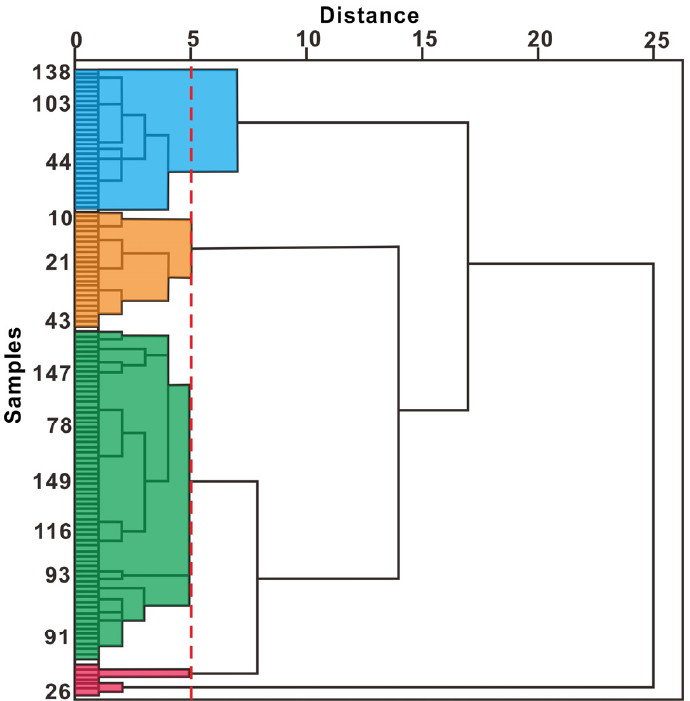
Figure 6. Dendrogram of clustering results in different pore-throat proportions. Determining the optimal number of clusters is critical to obtaining more convincing reservoir classification results. To determine the optimal cluster number, three cluster num- bers (i.e., 3, 4, and 5) were selected for the systematic clustering analysis. Figure 7 shows the relationship between the porosity and permeability of different types of reservoirs obtained by different cluster numbers. When the number of clusters is 3, the porosity and permeability data of different types of reservoirs overlap considerably, and the coincidence rate is only 69.4% (Figure 7a). When the number of clusters is 4, the conformity rate is 85.6% (Figure 7b). When the number of clusters is 5, the conformity rate is only 66.2% (Figure 7c). These results indicate that the optimal number of clusters is 4. Correspondingly, the Chang 7 1-2 shale oil reservoirs are classified into four